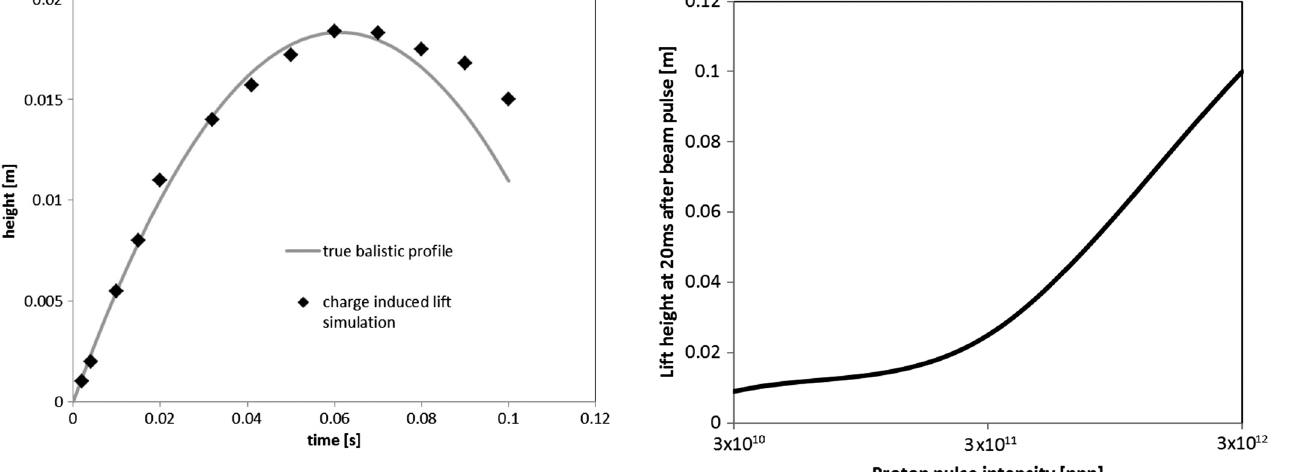
FIG. 18. Comparison between simulated lift trajectory and a true ballistic profile; 2 . 2 × 10 11 protons on target.